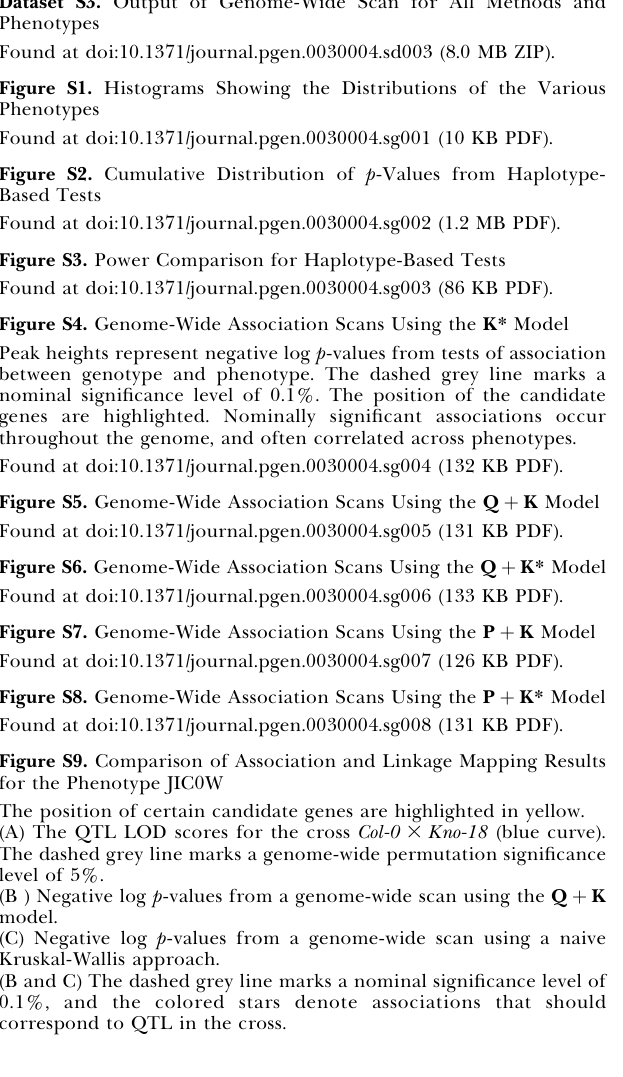
Figure S10. Comparison of Association and Linkage Mapping Results for the Phenotype JIC8W The position of certain candidate genes are highlighted in yellow. (A) The QTL LOD scores for three crosses: Col-0 3 RRS-10 (black curve), Col-0 3 Var2–6 (red curve), and Col-0 3 Ull2–5 (green curve). The dashed grey line marks a genome-wide permutation significance level of 5%. (B) Negative log p -values from a genome-wide scan using the Q þ K model. (C) Negative log p -values from a genome-wide scan using a naive Kruskal-Wallis approach. In (B) and (C), the dashed grey line marks a nominal significance level of 0.001, and the colored stars denote associations that should correspond to QTL in the cross displayed using the same color. Figure S11. The Top Two Principal Components from EIGENSTRAT Superimposed on Geographic Origins Found at doi:10.1371/journal.pgen.0030004.sg011 (54 KB PDF). Figure S12. Cumulative Densities of p -Values for Association between the AFLP Markers and Phenotypes Used by Olsen et al. [32] and Caicedo et al. [33] Found at doi:10.1371/journal.pgen.0030004.sg012 (11 KB PDF). Table S1. Mixed-Model Analysis of Previously Published Candidate Polymorphisms in CRY2 [32], FLC [33], and PHYC [34] Found at doi:10.1371/journal.pgen.0030004.st001 (17 KB PDF). Table S2. Basic Linear Model Analysis of Previously Published Candidate Polymorphisms in CRY2 [32], FLC [33], and PHYC [34] Found at doi:10.1371/journal.pgen.0030004.st002 (25 KB PDF). Table S3. Linear Model Analysis (Including a Locus by Latitude Interaction Term) of Previously Published Candidate Polymorphisms in CRY2 [32], FLC [33], and PHYC [34] Found at doi:10.1371/journal.pgen.0030004.st003 (18 KB PDF). Table S4. Linear Model Analysis (Including Both Locus by Latitude and Locus by FRI Interaction Terms) of Previously Published Candidate Polymorphisms in CRY2 [32], FLC [33], and PHYC [34] Found at doi:10.1371/journal.pgen.0030004.st004 (18 KB